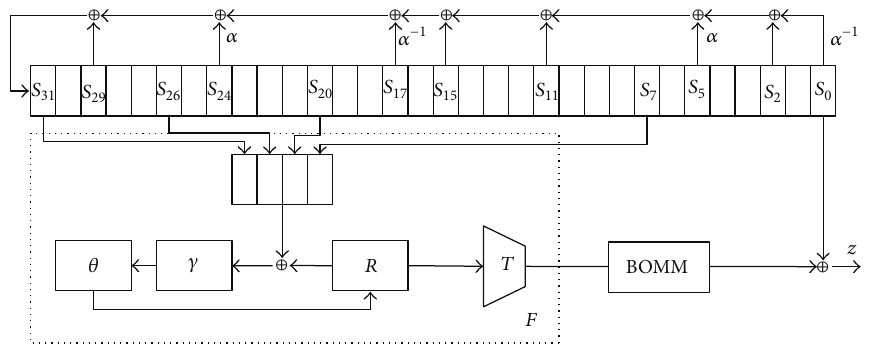
Figure 1: The structure of Loiss stream cipher.